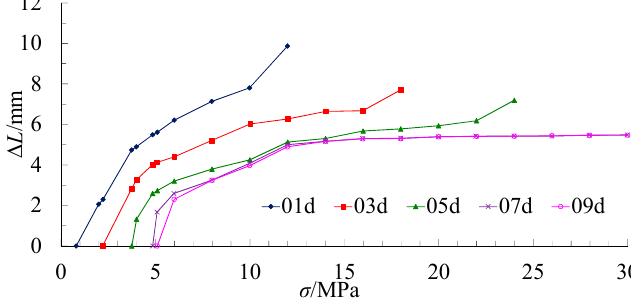
Figure 11. Deformation behaviour of specimens under different loads at different ages.